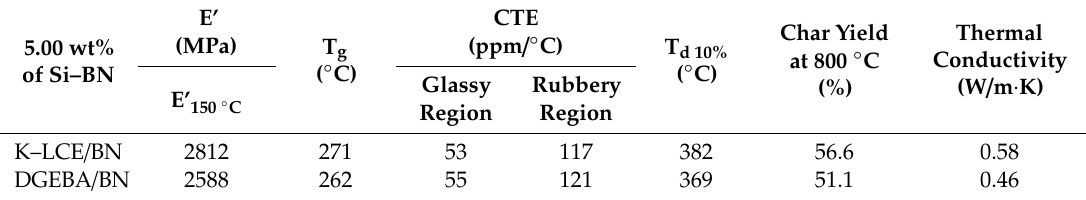
Table 3. Comparison of thermal and mechanical properties of K–LCE / BN and DGEBA / BN composites.